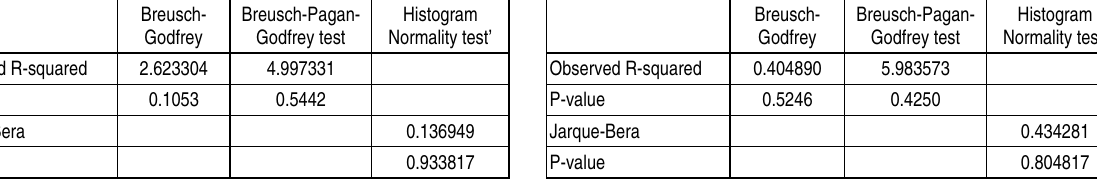
Table 1 . Summary of results of residual diagnostic test for regression model 1